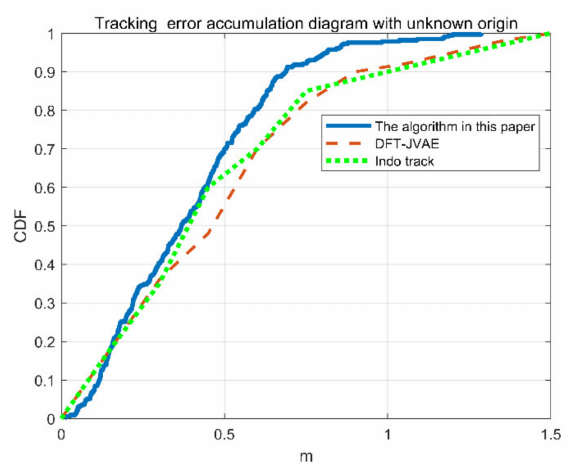
Figure 18. Tracking error compared with different